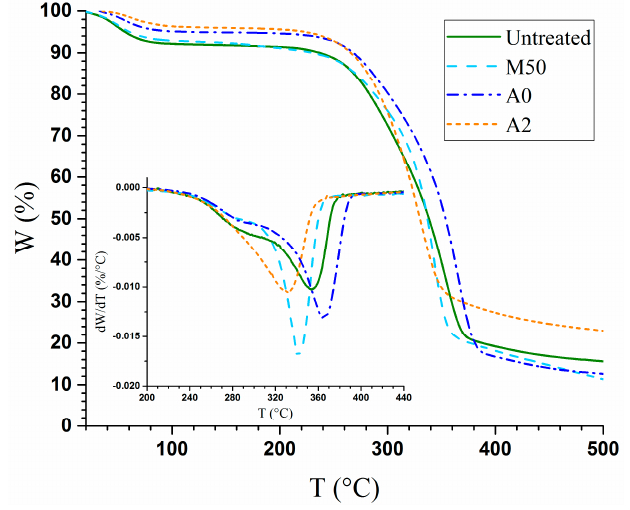
Figure 5. The thermal gravimetric analysis of untreated poplar and densified poplar wood sam-